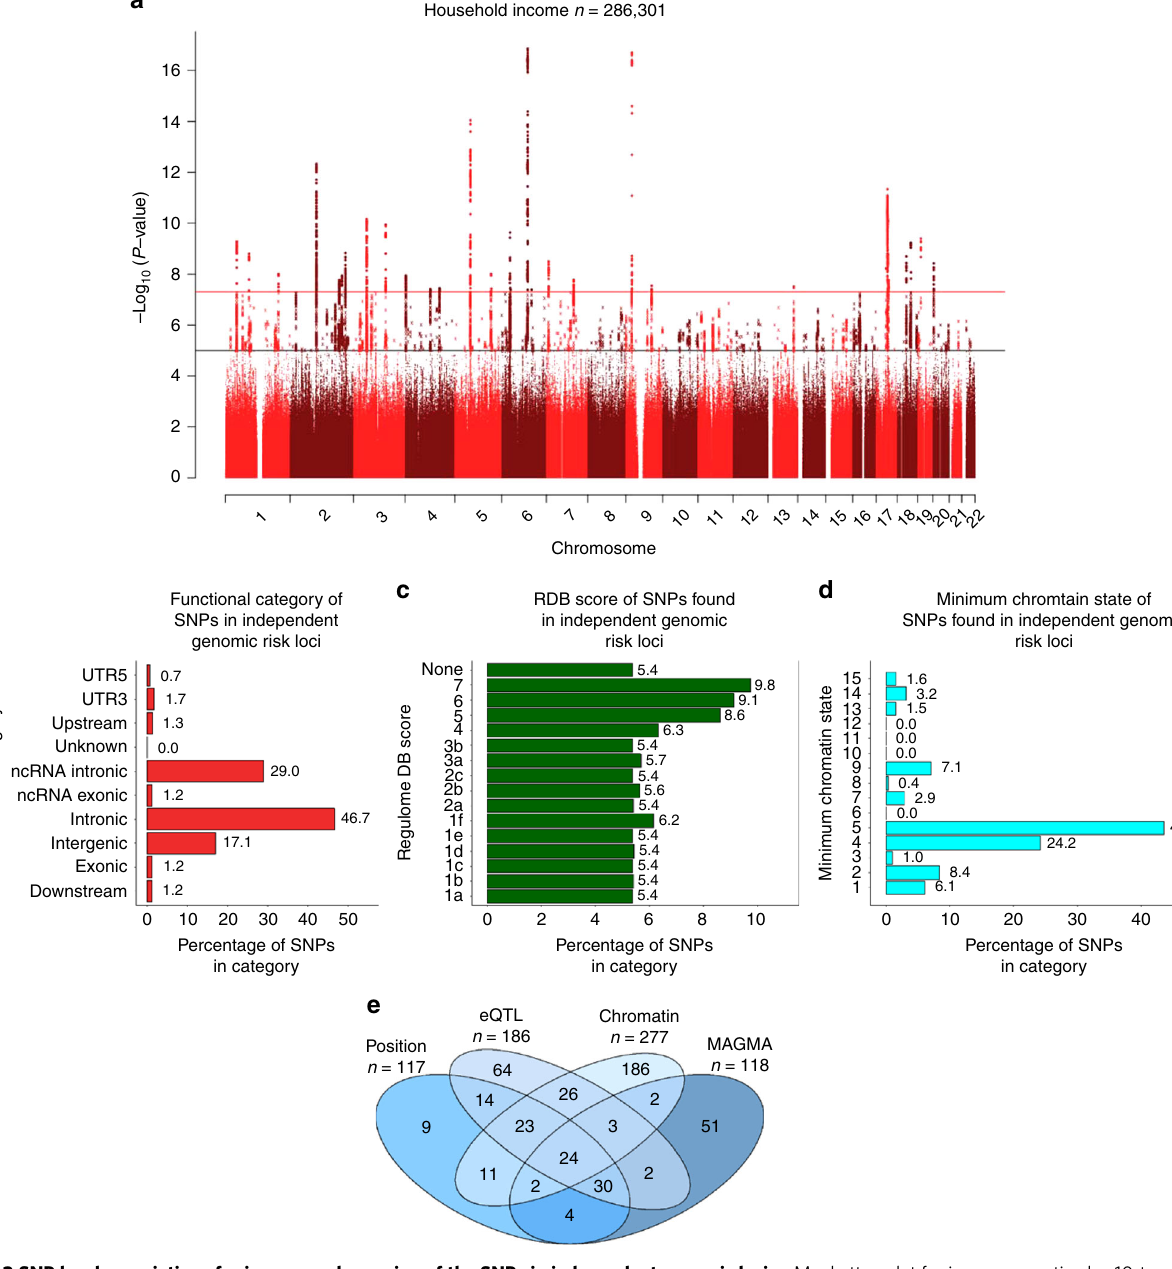
Fig. 3 SNP level associations for income and mapping of the SNPs in independent genomic loci. a Manhattan plot for income; negative log10-transformed P values for each SNP are plotted against chromosomal location. The red line indicates genome-wide signi fi cance and the black line indicates suggestive associations (1×10 − 5 ). b Functional annotation carried out on the independent genomic loci identi fi ed. The percentage of SNPs found in each of the nine functional categories is listed. c The percentage of SNPs from the independent genomic loci that fell into each of the Regulome DB scores categories. A lower score indicates greater evidence for that SNPs involvement in gene regulation. d The percentage of SNPs within the independent genomic loci plotted against the minimum chromatic state for 127 tissue/cell types. e Venn diagram illustrating the overlap of the genes implicated using positional mapping, eQTL mapping, chromatin interaction mapping, which was conducted on the independent signi fi cant loci identi fi ed in the SNP-based GWAS. Also shown is how these implicated genes overlap with those identi fi ed using the gene-based statistics derived using